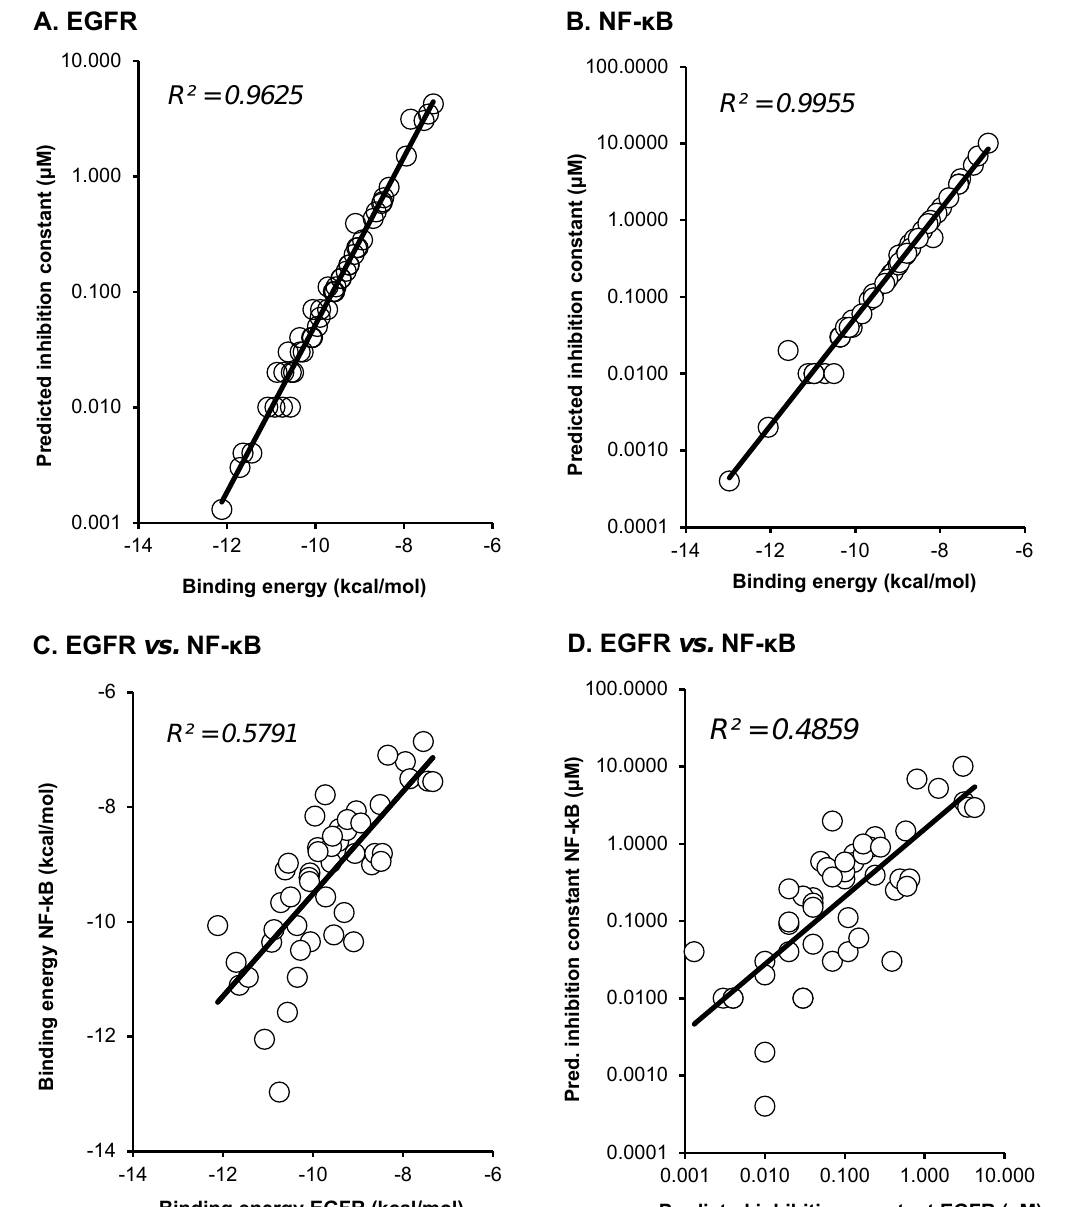
Figure 3. Correlation of binding energies (kcal/mol) and predicted inhibition constants (pKi, μ M) of 50 curcumin compounds were calculated using the Pearson correlation test. Correlation of binding energies and pKi values for ( A ) EGFR and ( B ) NF ‐κ B. Correlation of ( C ) binding energies or ( D ) pKi values between EGFR and NF ‐κ B.